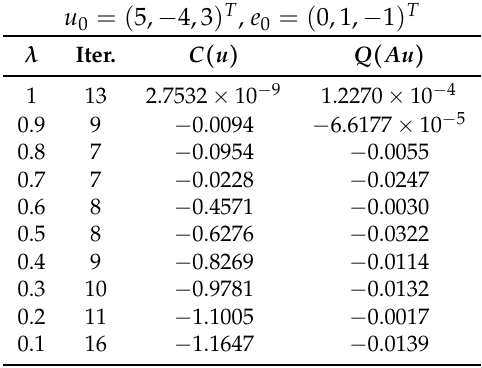
Table 3. Numerical results for solving Example 2 with different λ .